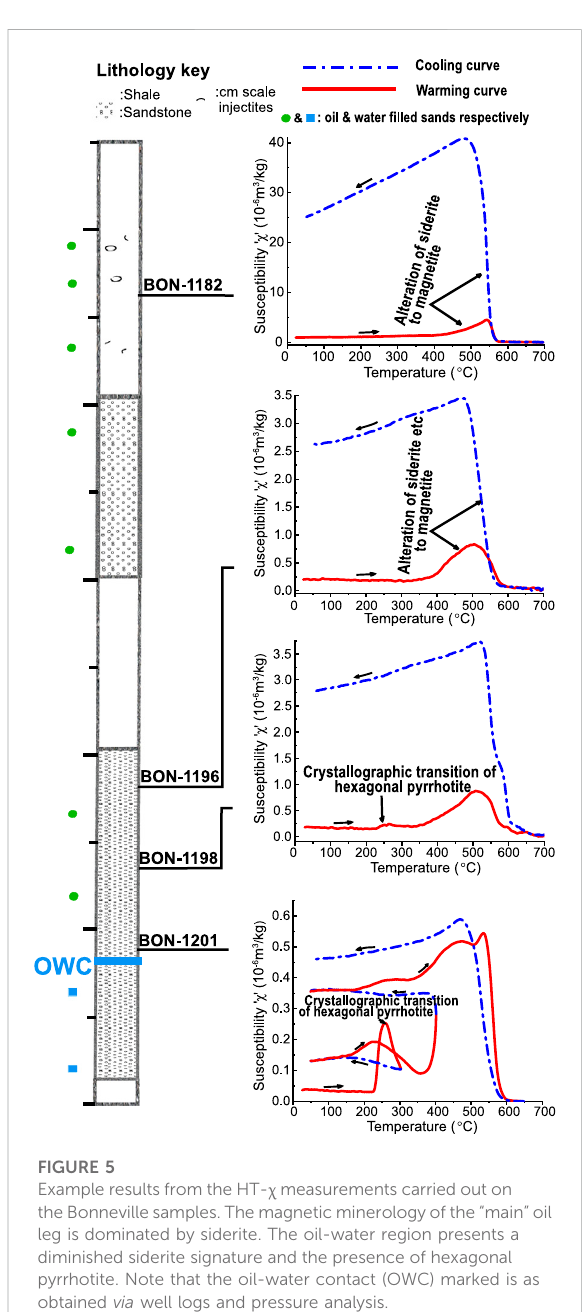
FIGURE 5 Example results from the HT- χ measurements carried out on theBonnevillesamples. The magnetic minerology ofthe “ main ” oil leg is dominated by siderite. The oil-water region presents a diminished siderite signature and the presence of hexagonal pyrrhotite. Note that the oil-water contact (OWC) marked is as obtained via well logs and pressure